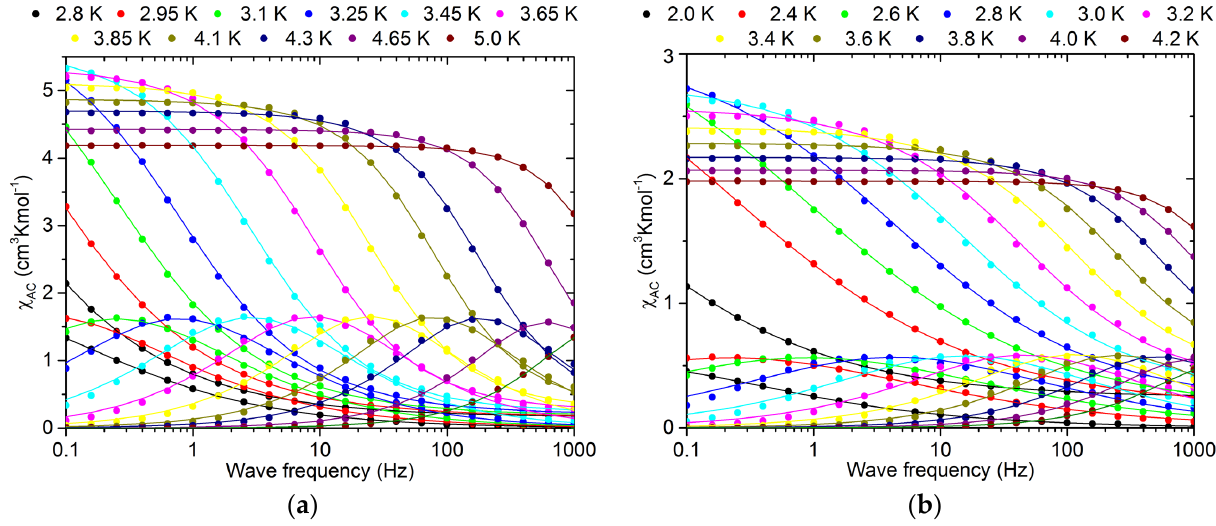
Figure 7. ac susceptibility measured for 1 ( a ) and 2 ( b ) at selected temperatures versus ac frequency. Solid lines were fitted simultaneously to χ ’( ν ) and χ ’’( ν ) curves using a generalized Debye relaxation model.